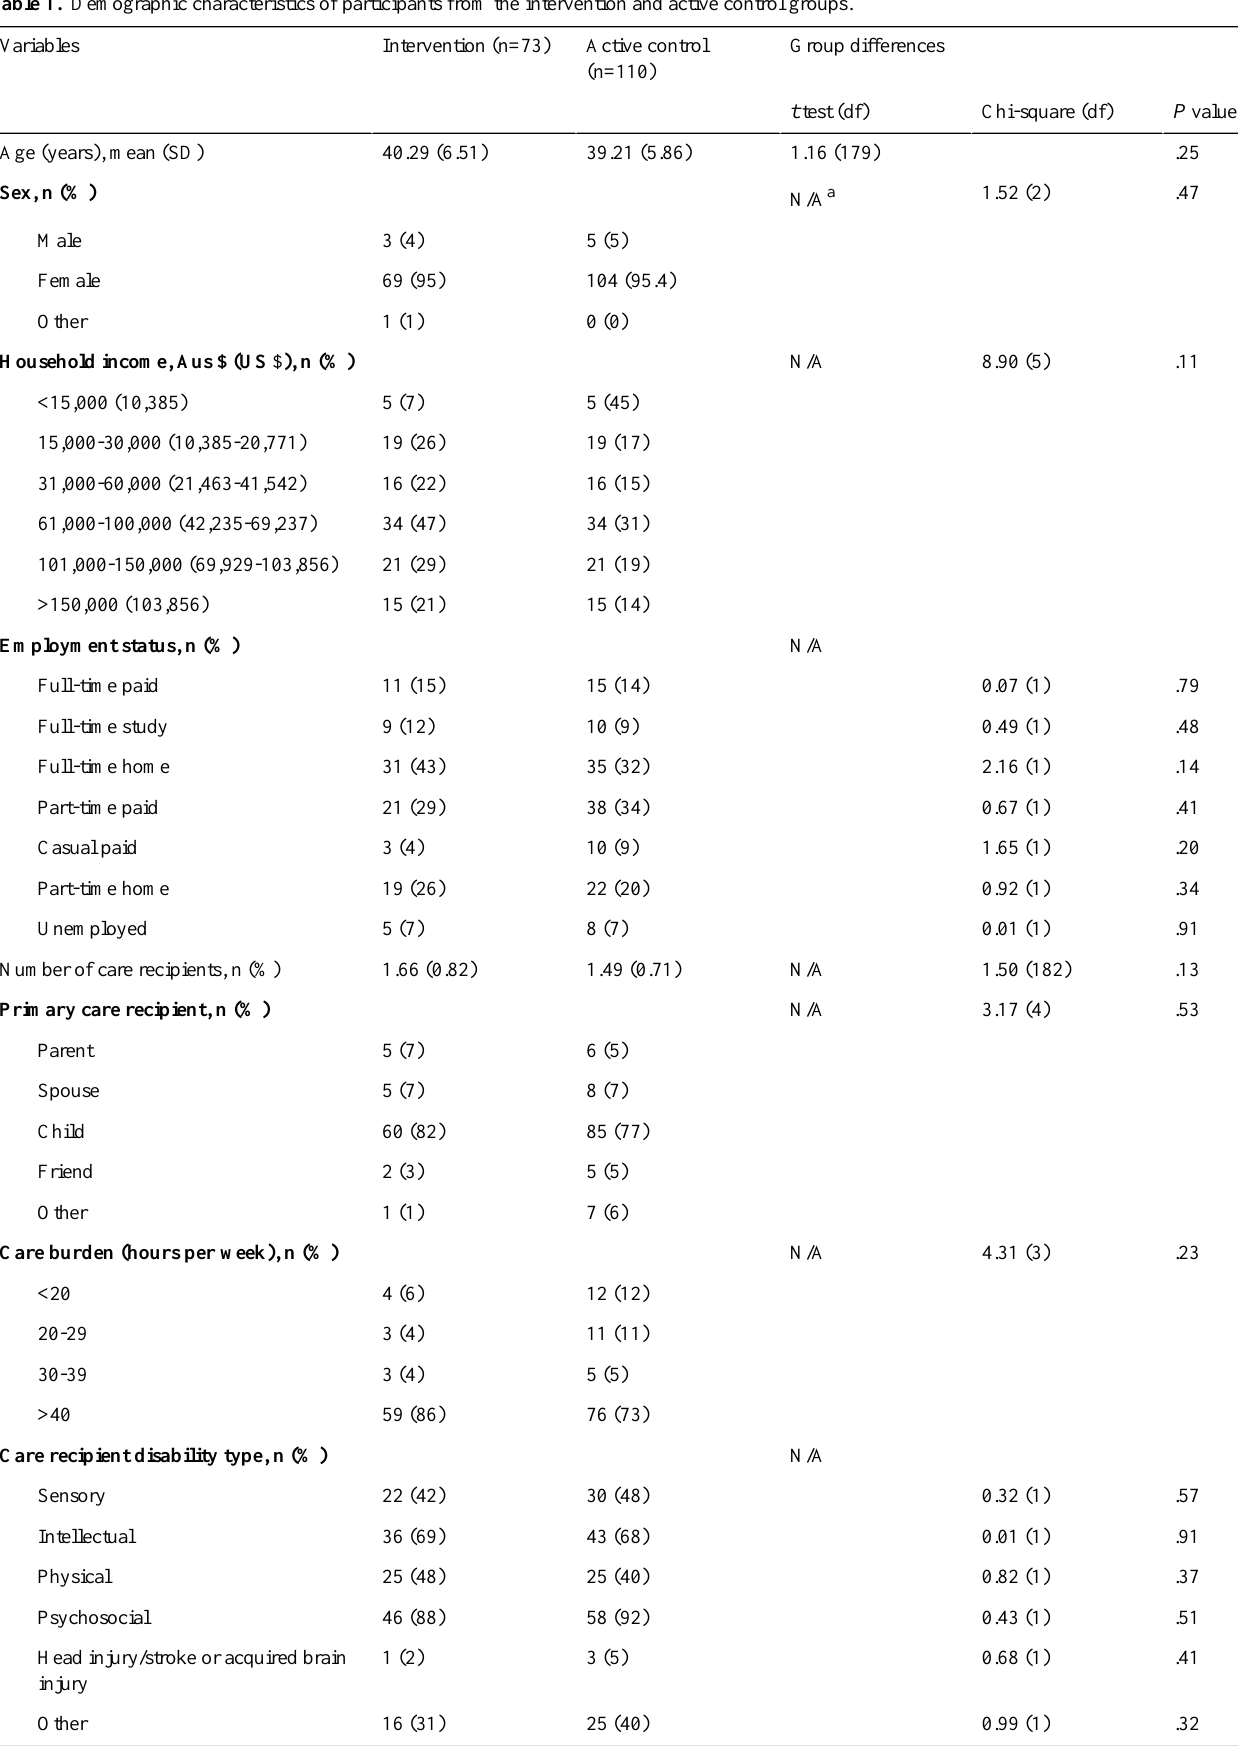
Table 1. Demographic characteristics of participants from the intervention and active control groups.